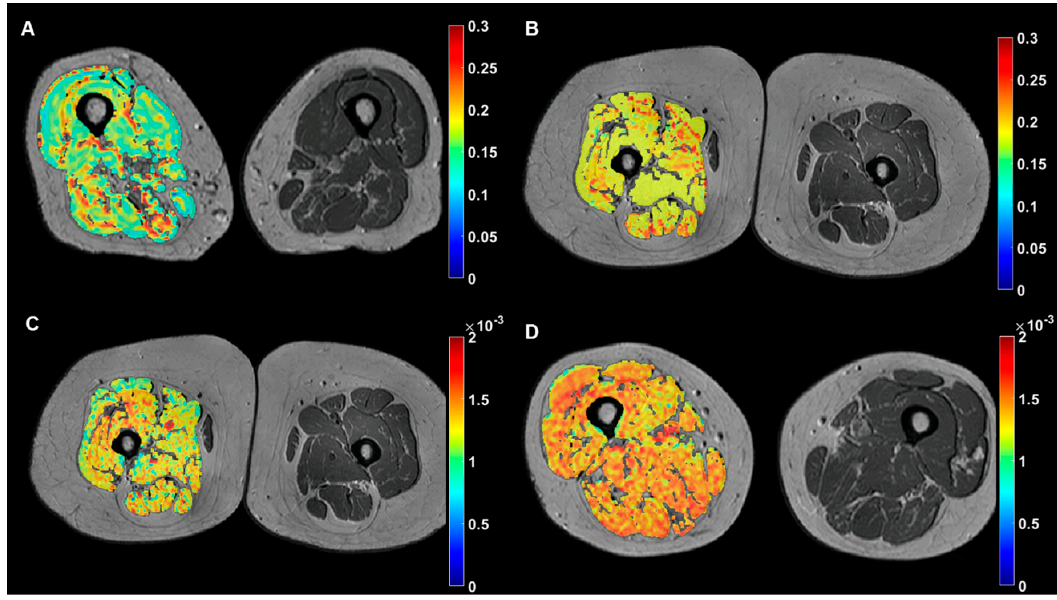
Figure 2. Examples of representative color-coded imaging biomarkers of the dominant leg muscle overlapped on anatomic MR images of the thighs. Top row: microscopic fat infiltration (PDFF, no units) maps showing lower values for a subject with relatively low fat mass ( A ) in comparison with a subject with high fat mass ( B ). Bottom row: muscle hydration maps ( D , mm 2 /s) showing lower values for a subject with IPAQ 1 ( C ) in comparison with a subject with IPAQ 2 ( D ).